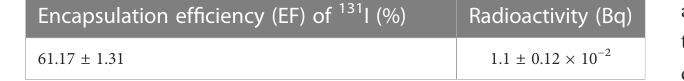
TABLE 1 Encapsulation ef fi ciency (EF) of 131 I and the radioactivity of a single nanoparticle. Encapsulation ef fi ciency (EF) of 131 I